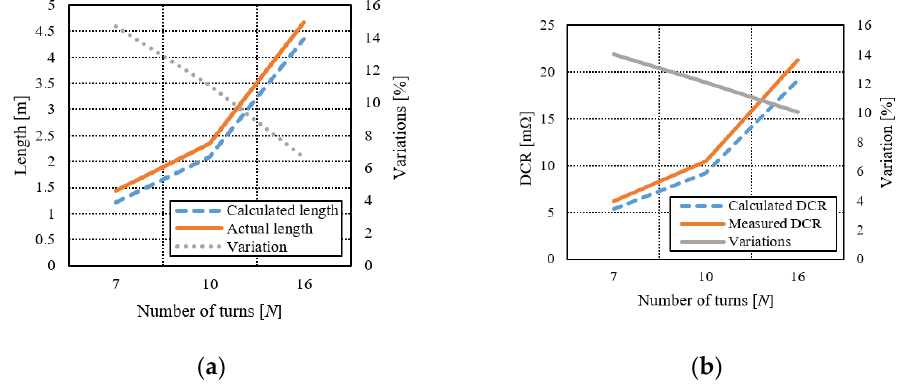
Figure 8. Comparison of calculated and measured length and DCR. ( a ) Length comparison. ( b ) DCR comparison.